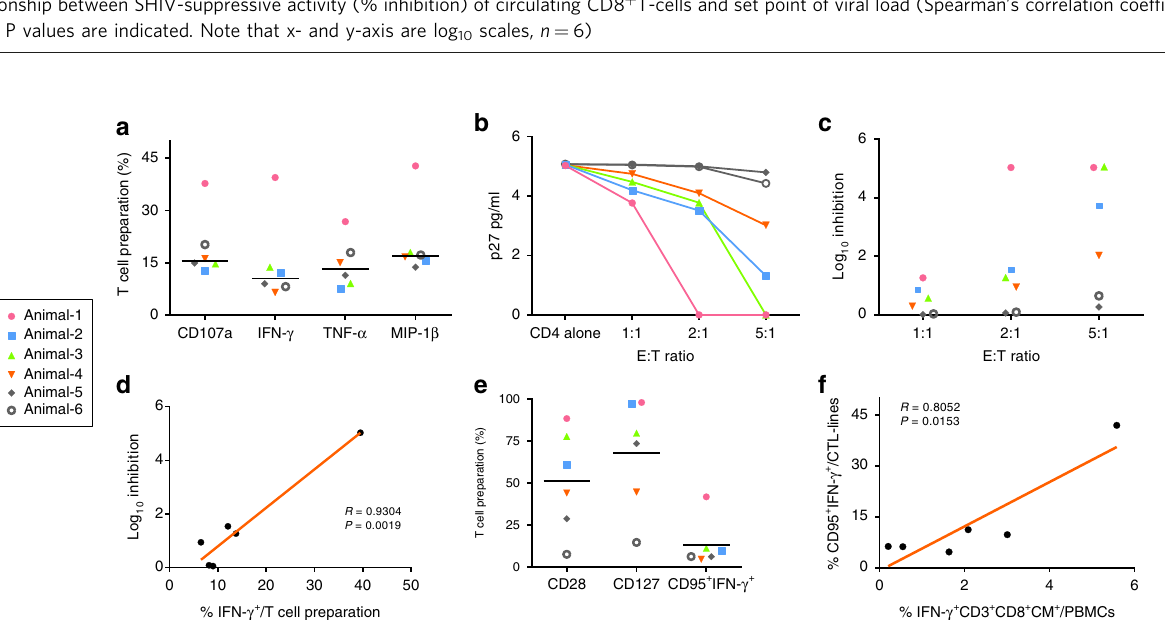
Fig. 3 Phenotypic and functional characteristics pre- and post CTL infusion. a Functional pro fi les of CD8 + T-cells pre- and post- CTL were evaluated by peptide antigen-speci fi c responses and shown as the frequencies of Env-speci fi c CD8 + T-cells producing CD107a, IFN- γ , MIP-1 β and TNF- α ( p < 0.0001 using Wilcoxon signed-rank test, n = 6). b Activation pro fi le of Env-speci fi c, IFN- γ -producing CD8 + T-cells for both pre- and post-infusion responses, based on surface expression of CD69, HLADR, CCR5 and intracellular expression of Ki67 (* p < 0.05 and ** p < 0.01 using unpaired Students t test, Mean± s.d. are presented in all graphs, n = 6). c Env-peptide functional pro fi les of CD8 + T-cells in controllers, non-controllers and untreated animals ( p < 0.0001 using Wilcoxon signed-rank test, n = 8). d Env-speci fi c, IFN- γ + CD3 + CD8 + central memory T cells pre-and post-CTL infusion among controllers, non-controllers